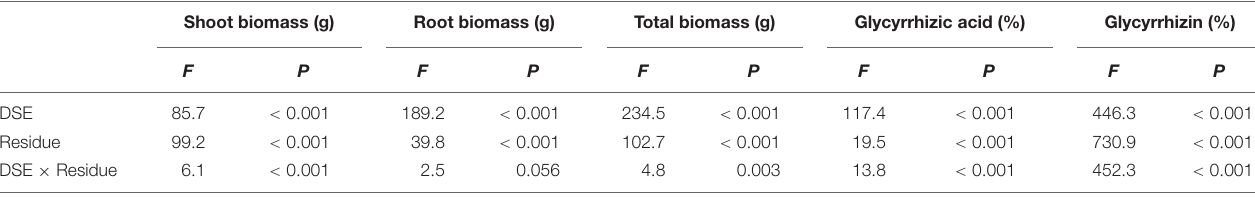
TABLE 2 | Analysis of variance (ANOVA) for the effects of dark septate endophyte (DSE) inoculation and residue treatment (Residue) on plant biomass and active ingredient content of liquorice plants. Shoot biomass (g) Root biomass (g)